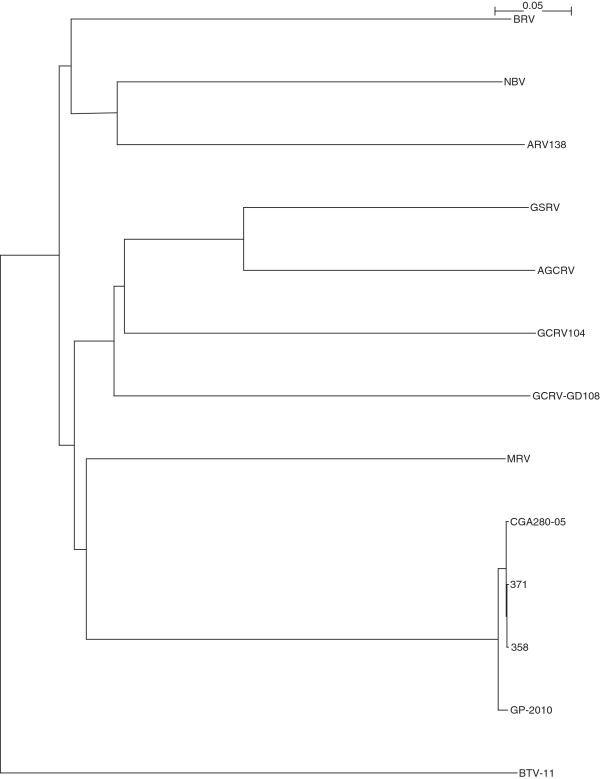
Phylogeny of homologous segment L2 shared by piscine reovirus (PRV) and selected members of familyReoviridae.